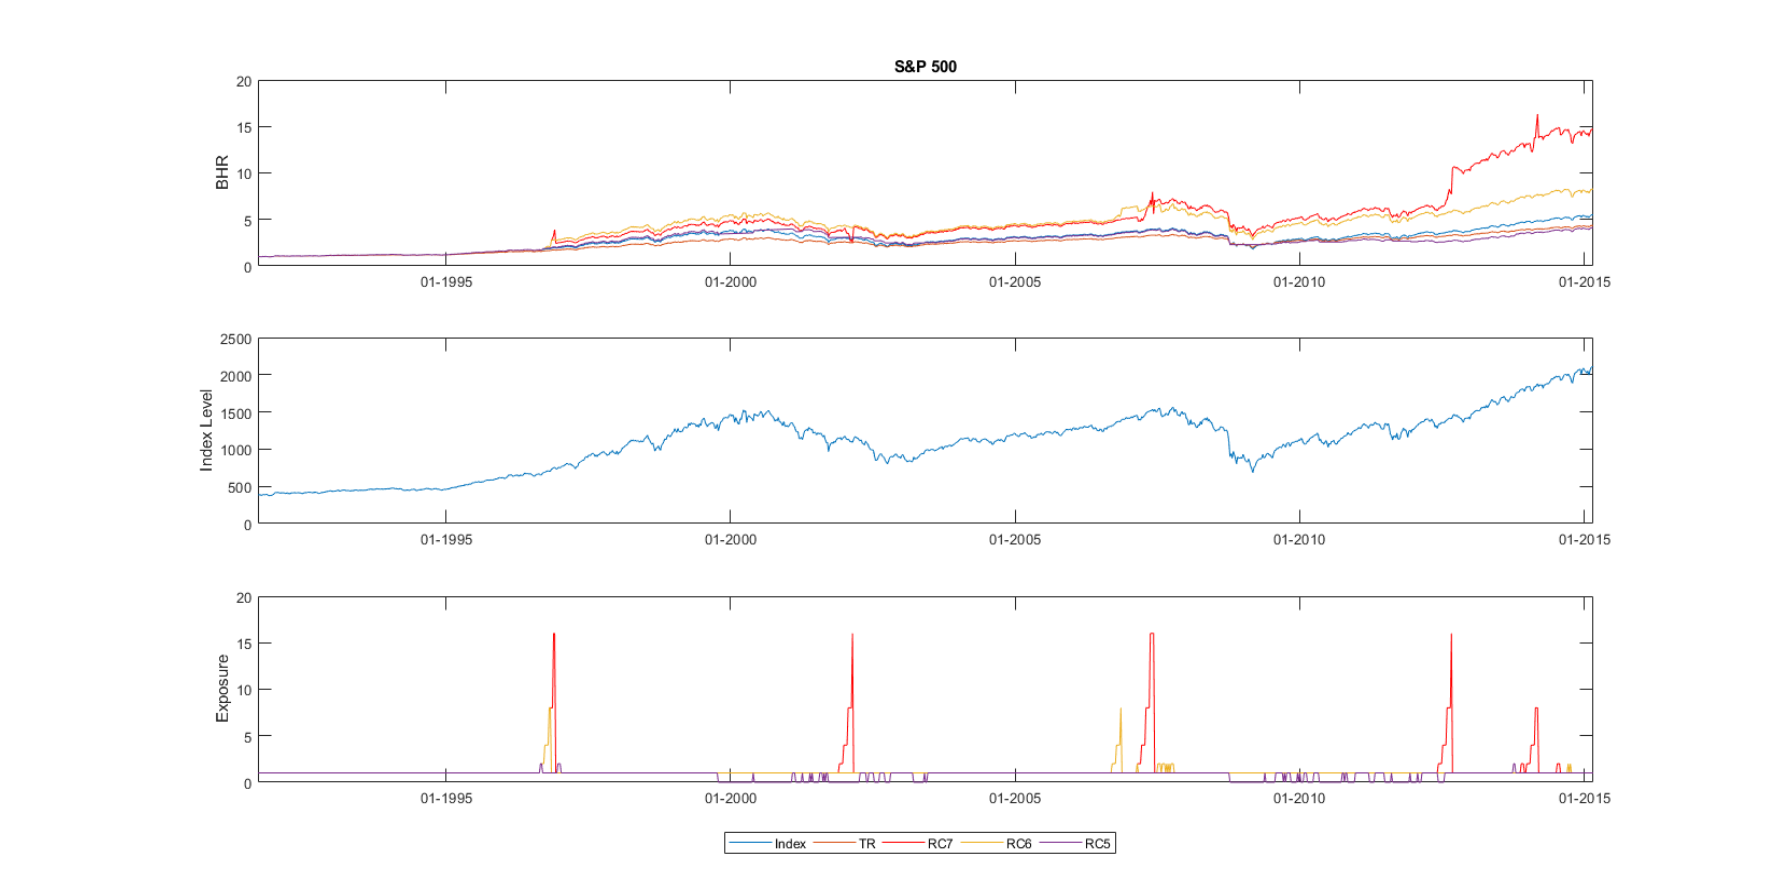
Figure 2. This figure displays the Buy and Hold returns (BHRs) of the volatility-based strategies, the index level and the exposures induced by the trading